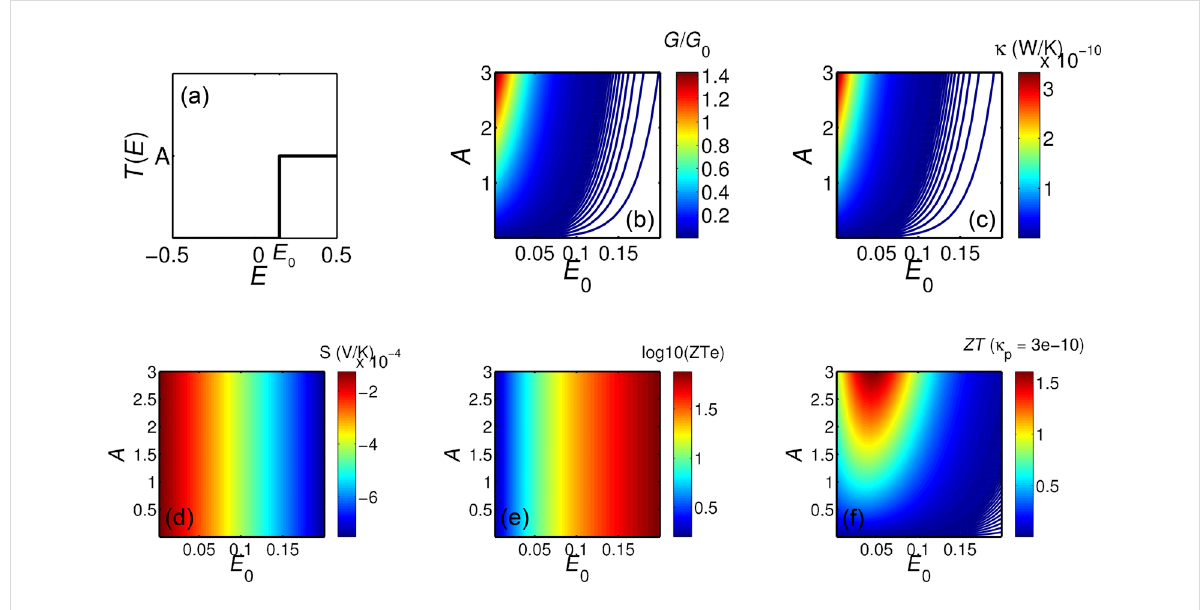
Figure 4: (a) Ideal step function like transmission coefficient T ( E ) asymmetric around Fermi energy ( E = 0), (b) electrical conductance ( G ), (c) thermal conductance ( κ ), (d) Seebeck coefficient ( S ) and (e) electronic and (f) full figure of merit as a function of position of step function E 0 and the amplitude of T ( E